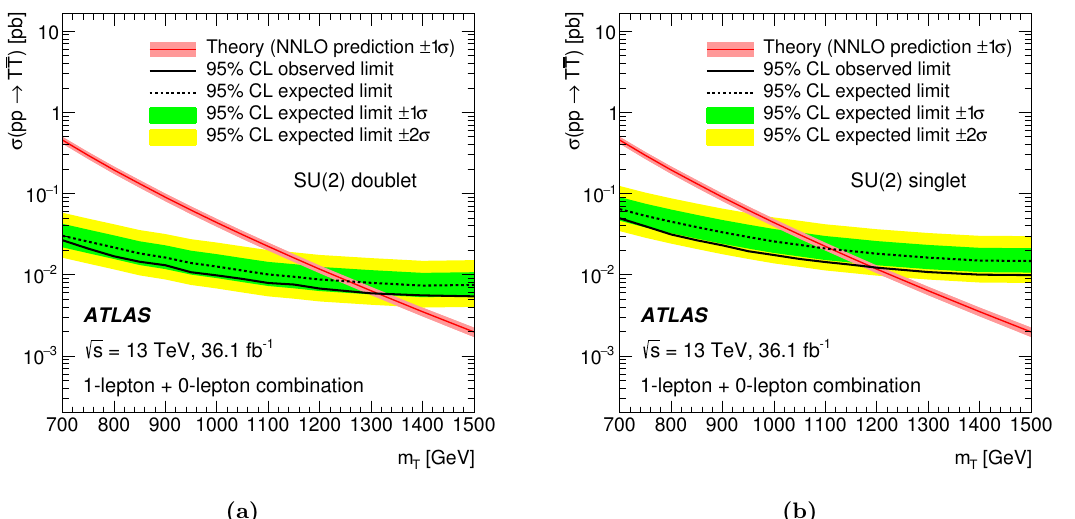
Figure 17. Observed (solid line) and expected (dashed line) 95% CL upper limits on the T (cid:22) T cross section as a function of the T quark mass for the combination of the 1-lepton and 0-lepton searches (a) for a T quark doublet, and (b) for a T quark singlet. The background estimate used in the com- putation of the limits is the result obtained from the background-only (cid:12)t to data. The surrounding shaded bands correspond to 1 and 2 standard deviations around the expected limit. The thin (cid:6) (cid:6) red line and band show the theoretical prediction and its 1 standard deviation uncertainty. (cid:6)